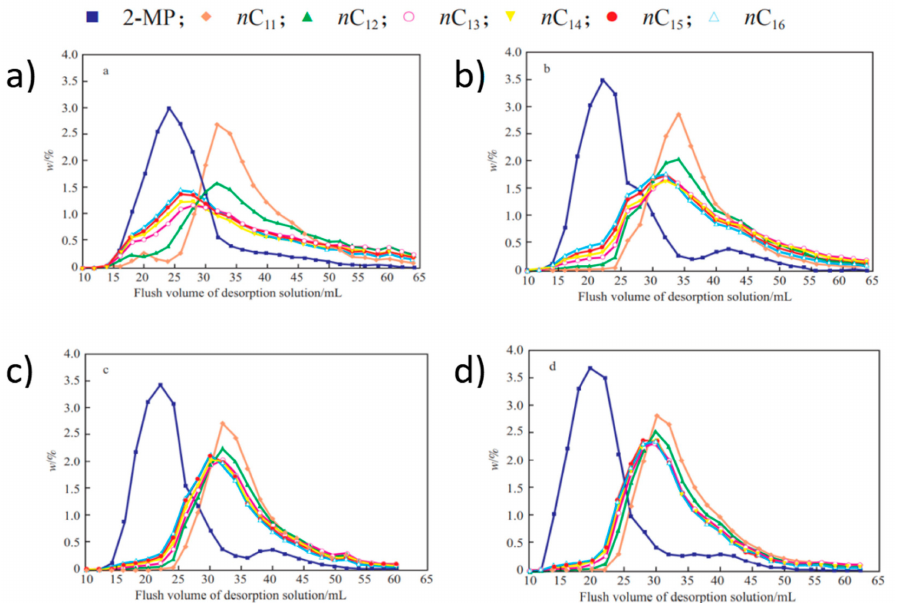
Figure 5. Pulse spectra of nC 11–16 at different adsorption temperatures [36]. ( a ) 120 ◦ C ( b ) 150 ◦ C